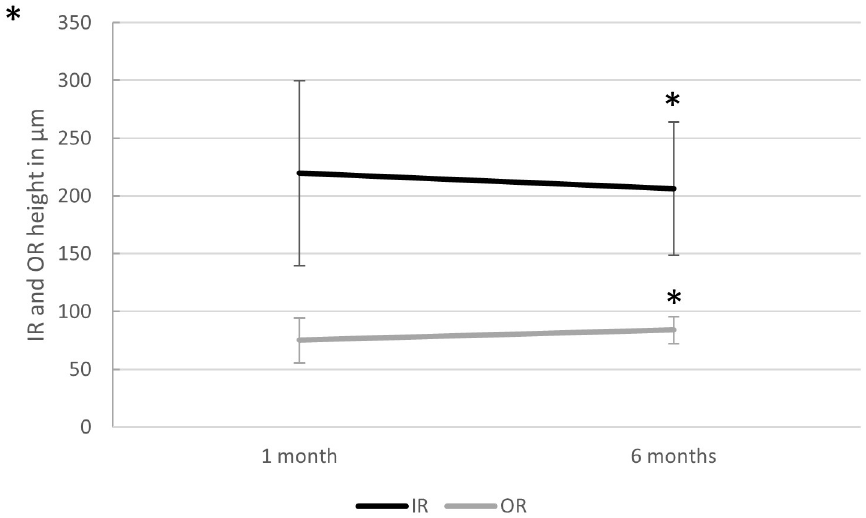
Fig 7. Inner and outer retinal height changes. Change in subfoveal inner (IR) and outer (OR) retina height 1 and 6 months after vitrectomy with gas endotamponade for macula-involving primary retinal detachment. A slight but significant decrease in IR and increase in OR were seen. Mean IR thickness decreased from 219.7 ± 79.8 μ m to 206.2 ± 57.6 μ m, and OR increased from 75.3 ± 19.5 μ m to 83.9 ± 11.8 μ m (Friedman test for correlated samples p = 0.014 for IR, and p = 0.0005 for OR, n = 74 at 1 month and n = 73 at 6 months). Whiskers indicate standard deviations, and asterisks ( � ) indicate significant differences compared to 1 month (p < 0.01).